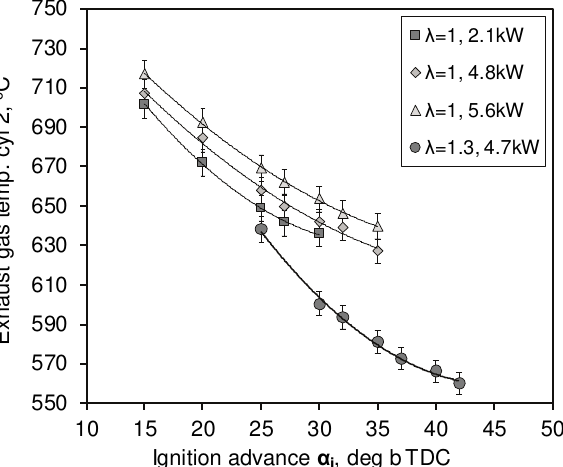
Fig. 11. Exhaust gas temperature measured on cylinder 2 outlet vs ignition timing, throttle position and mixture